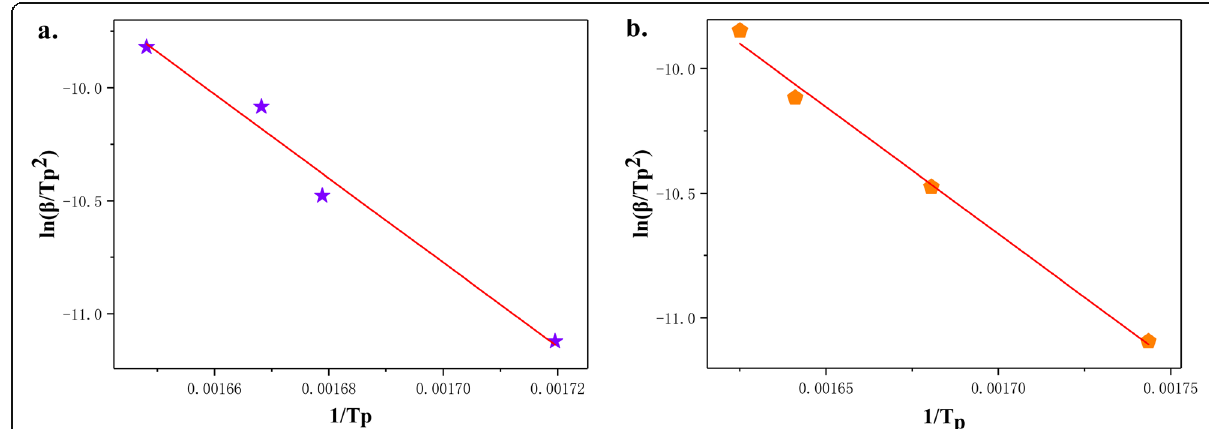
Fig. 9. Fitting results of ln( β /T p 2 ) and 1/T p of a AP/MOF-5 and b AP/GO@MOF-5